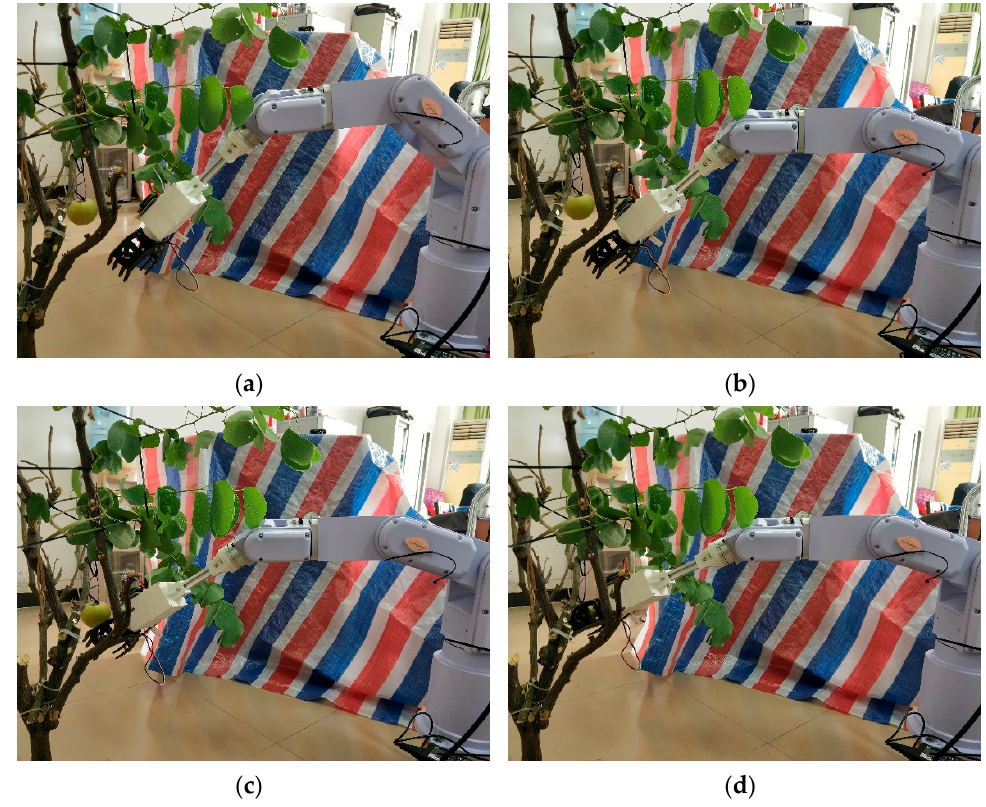
Figure 15. Motion process of apple picking with picking manipulator; ( a ) initial motion state of manipulator; ( b ) intermediate motion state 1; ( c ) intermediate motion state 2; ( d ) final arrival state of the manipulator.